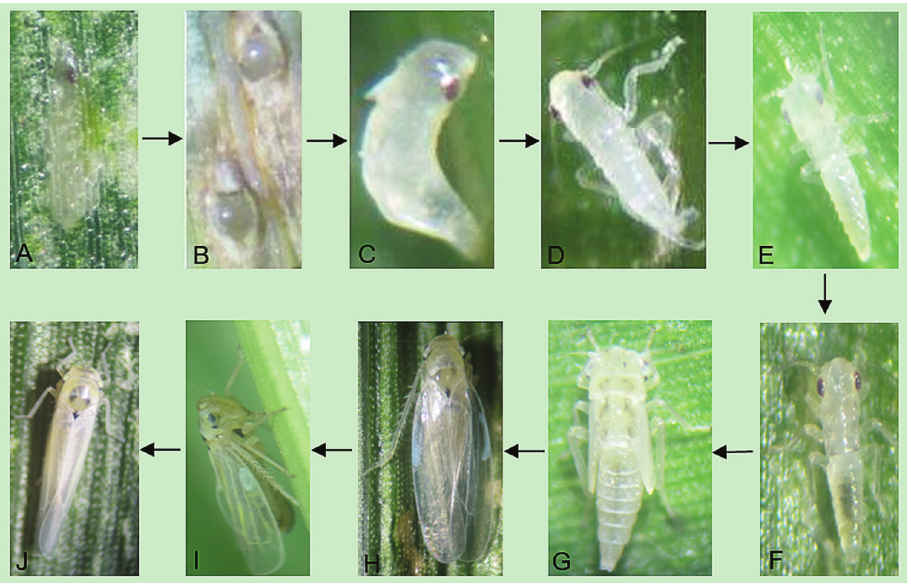
Figure 5. Life cycle of Zyginidia eremita : A, B , egg C–G nymphs H–J adults.